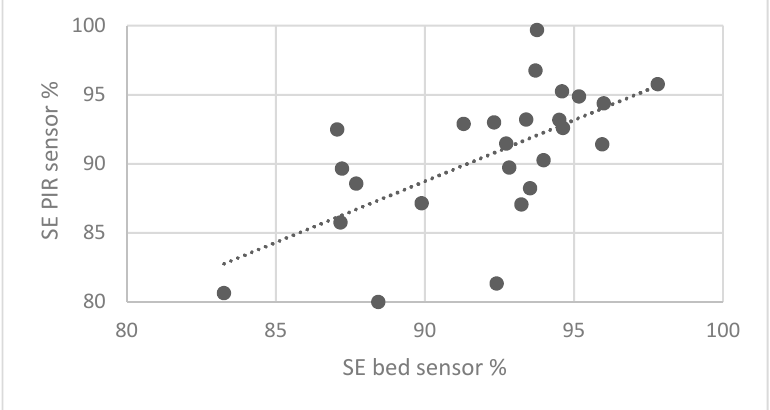
Figure 6. Plot and linear regression for the sleep efficiency (SE) parameters.